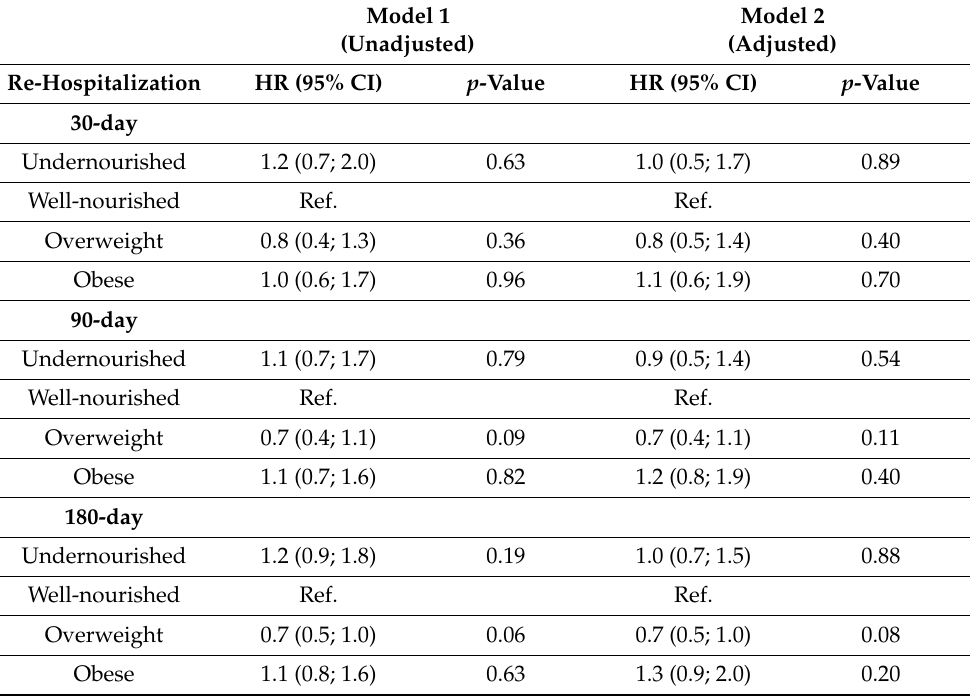
Table 3. Risk of re-hospitalization and mortality within 30, 90, and 180 days after discharge among undernourished, well-nourished (reference), overweight, and obese patients hospitalized with community-acquired pneumonia.